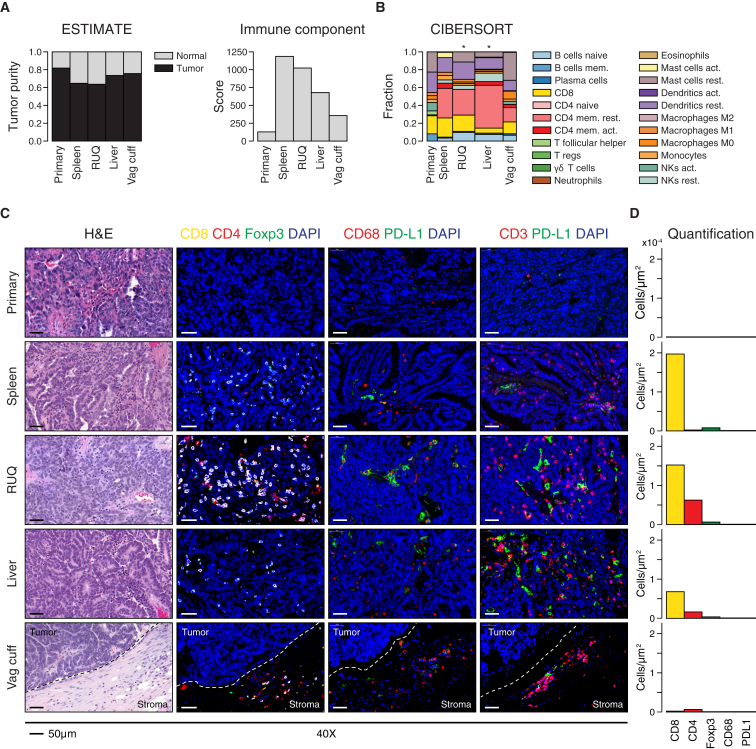
Immune Infiltration Status Shows Heterogeneous Microenvironments across Tumor Samples(A) Tumor purity and immune component estimated by analyzing Affymetrix-based transcriptomics (Table S3A) (Yoshihara et al., 2013).(B) Fractions of immune cell subsets in tumor samples inferred from gene-expression data using CIBERSORT (Newman et al., 2015). Width of bars is proportional to the −log10 p value of the deconvolution (Table S3B). CIBERSORT empirical p value, ∗p < 0.05.(C) Representative images of hematoxylin and eosin staining of tumor samples and immunofluorescence staining for DAPI, cytotoxic T cells (CD8+), helper T cells (CD4+FOXP3−), T cells (CD3+), T-regs (CD4+FOXP3+), macrophages (CD68+), and immune-checkpoint PD-L1. Complete slides are shown in Figure S3.(D) Image-based cell quantification of whole slides (Table S3C).